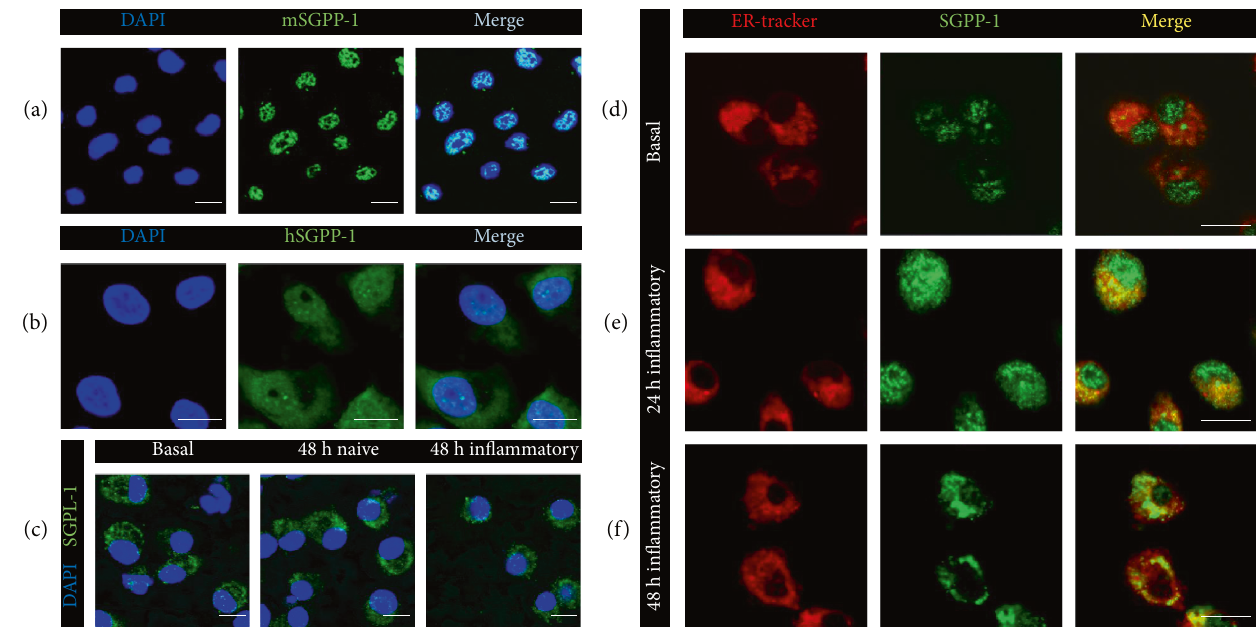
Figure 3: (a – f) Representative pictures of confocal laser microscopy of (a) untreated mature GM-CSF-di ff erentiated murine bone marrow-derived dendritic cells stained with murine anti-SGPP-1 antibody (green) and DAPI (blue) ( n = 5 ), (b) untreated mature human monocyte-derived dendritic cells stained with human anti-SGPP-1 antibody (green) and DAPI (blue) ( n = 3 ), (c) untreated mature murine GM-CSF-di ff erentiated dendritic cells (basal), after 48 h of starvation (naive) and 48 h of LPS stimulation (in fl ammatory) stained with DAPI (blue) and anti-SGPP-1 antibody (green) as indicated ( n = 3 ), and (d – f) mature GM-CSF-di ff erentiated murine dendritic cells stained with ER tracker (pseudocolor red) and anti-SGPP-1 antibody (green) (d) under basal conditions, (e) after 24h of LPS stimulation, and (f) after 48 h of LPS stimulation ( n = 3